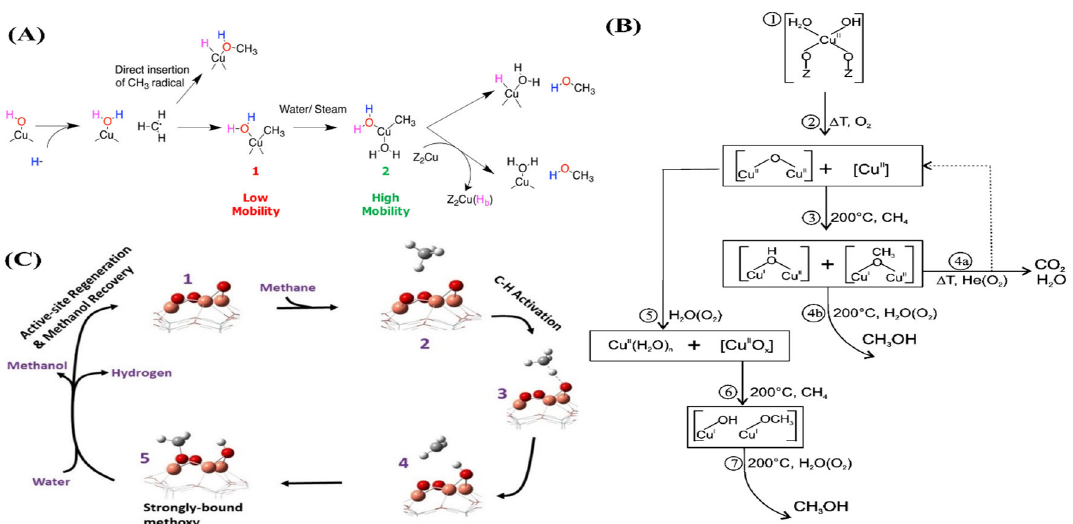
Figure 4. ( A ) Reaction scheme for partial methane oxidation to methanol for 8MR-[CuOH] + active site in Cu-exchanged CHA. Reprinted/adapted with permission from Ref. [106]. Copyright 2016, copyright American Chemical Society, ( B ) proposed scheme of structural changes in the active Cu species in Cu–mordenite based on former studies, mass spectrometry, UV-visible spectrometry, infrared spectroscopy, and quick XAS data. Reprinted/adapted with permission from Ref. [79]. to methanol by the [Cu 3 O 3 ] 2+ active site, steam-facilitated extraction of products, and regeneration of the active copper oxo cluster. Cluster model H, O, Al, Si and Cu atoms are represented with white, red, light pink, grey and brown spheres, respectively. Reprinted/adapted with permission from Ref. [109]. Copyright 2021, copyright Willy-VCH